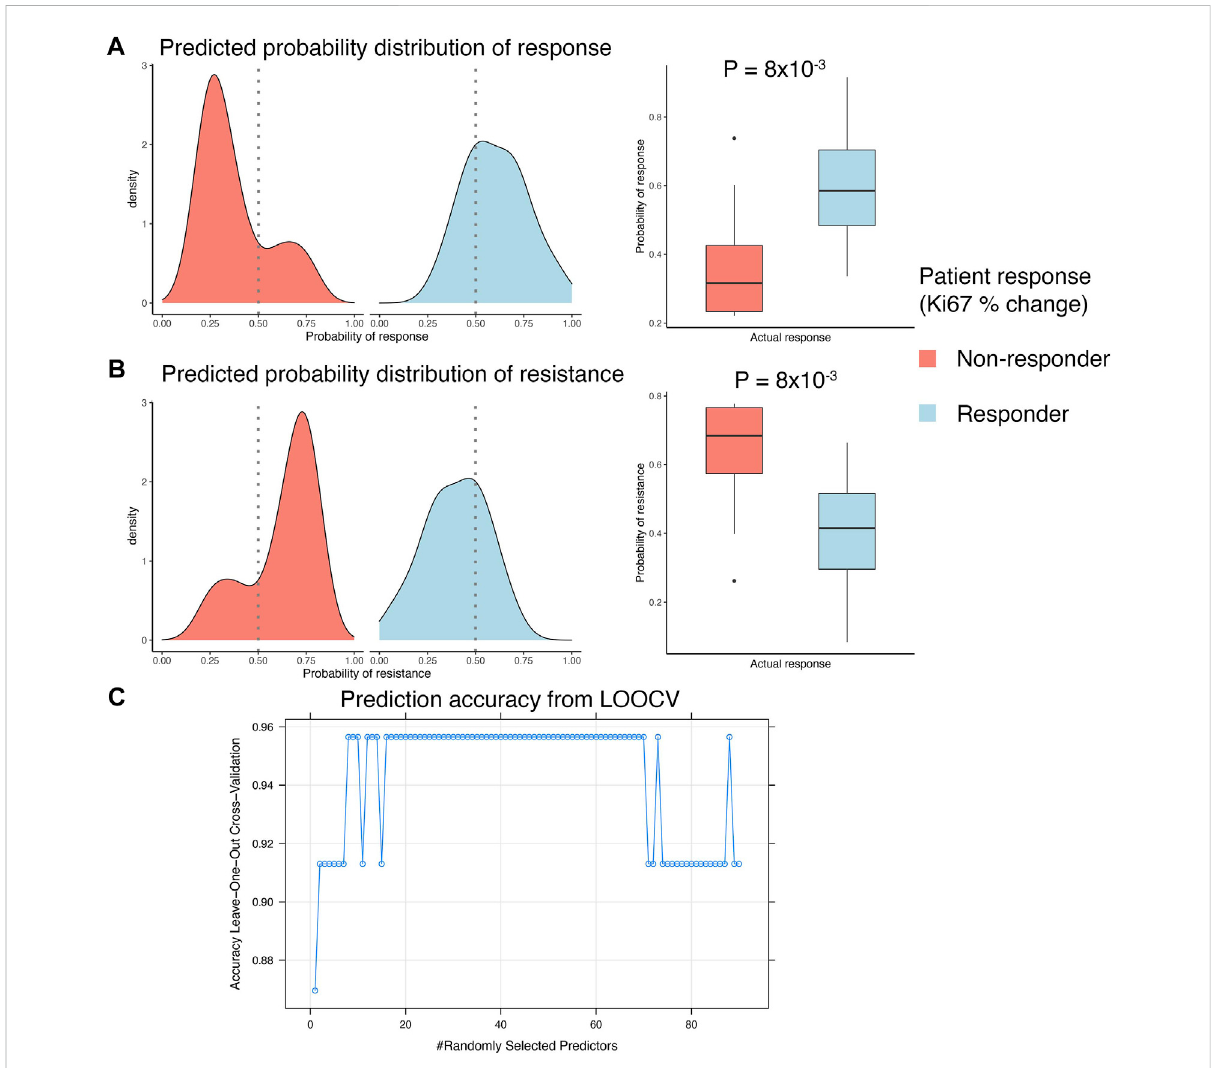
FIGURE 4 Developing integrated model with patient response data. (A,B) LOOCV analysis of the GSE119262 datasets comparing the prediction probabilities of (A) response or (B) non-response (resistance) calculated using the integrated model combining the in vitro response signature with the FCBF-selected features. The density plots on the left show distribution of the prediction probabilities in samples grouped by actual clinical response, with red indicating patients that were clinical non-responders ( < 10% decrease in Ki67% staining after 2 – 4 weeks) and blue